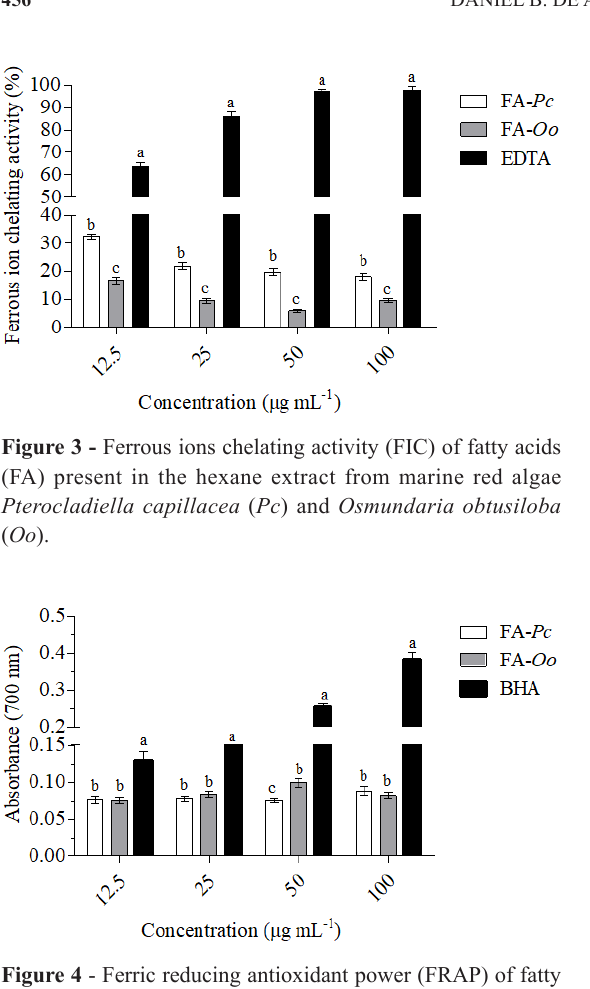
Figure 4 - Ferric reducing antioxidant power (FRAP) of fatty acids (FA) present in the hexane extract from marine red algae Pterocladiella capillacea ( Pc ) and Osmundaria obtusiloba ( Oo